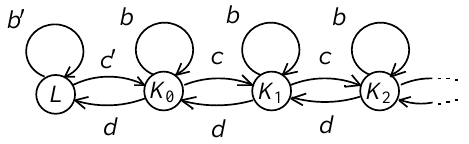
Fig. 1: One-sided “linear” graph (with transition probabilities)